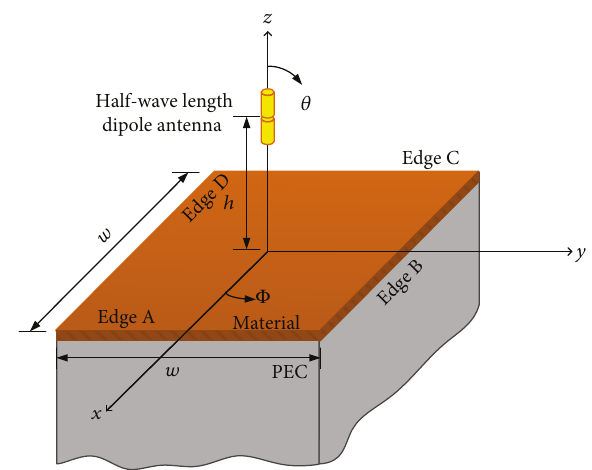
Figure 16: Material-coated PEC square tower platform excited by a simple half-wavelength dipole antenna.